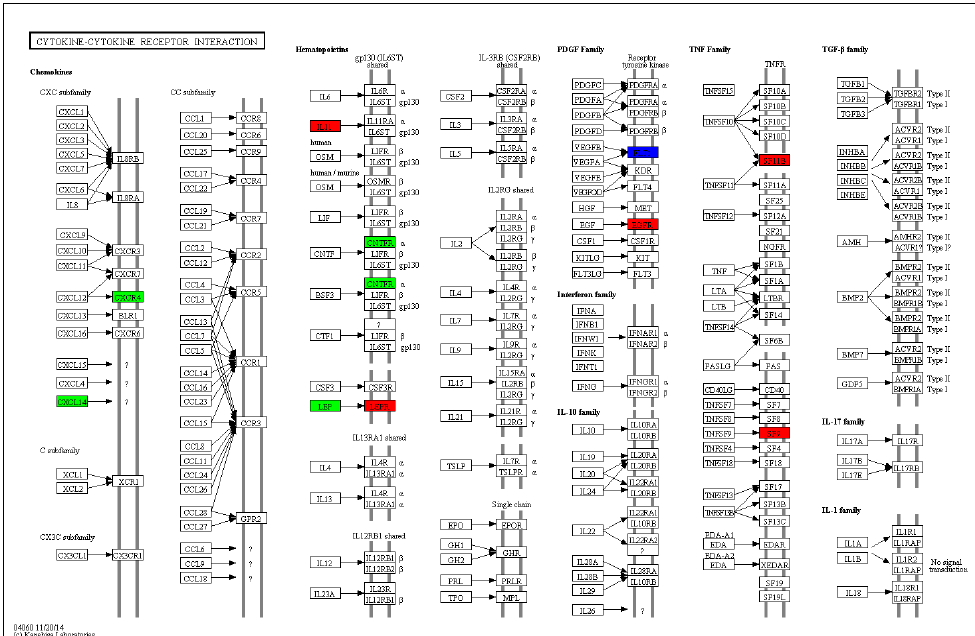
Figure 10. Significantly differentially expressed genes identified by KEGG that are involved in the cytokine-cytokine receptor interaction signaling pathway. Red boxes indicate upregulated DEGs; Green boxes represent downregulated DEGs; Blue boxes show no changes in expression. (For interpretation of colors used in this figure, please refer to the web version of this article).